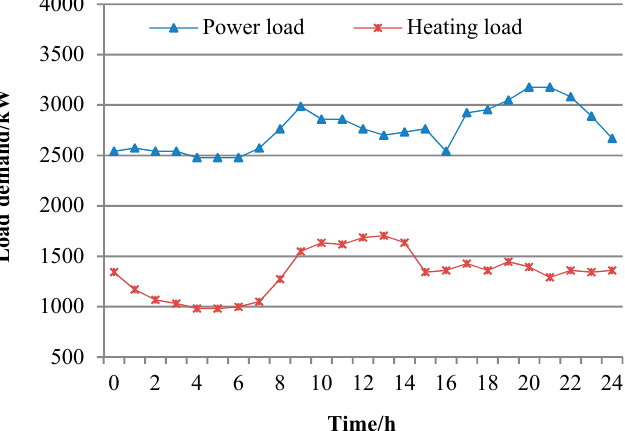
Figure 6. Demand load distribution of electricity and heating in typical daily load.